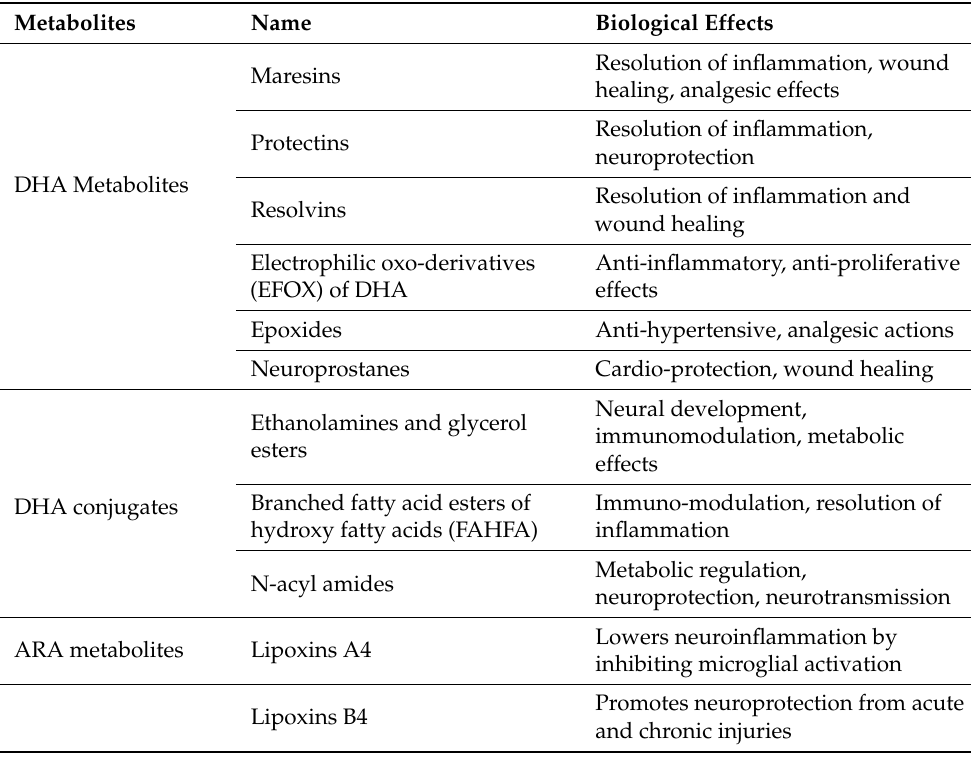
Table 1. Functions of DHA and ARA